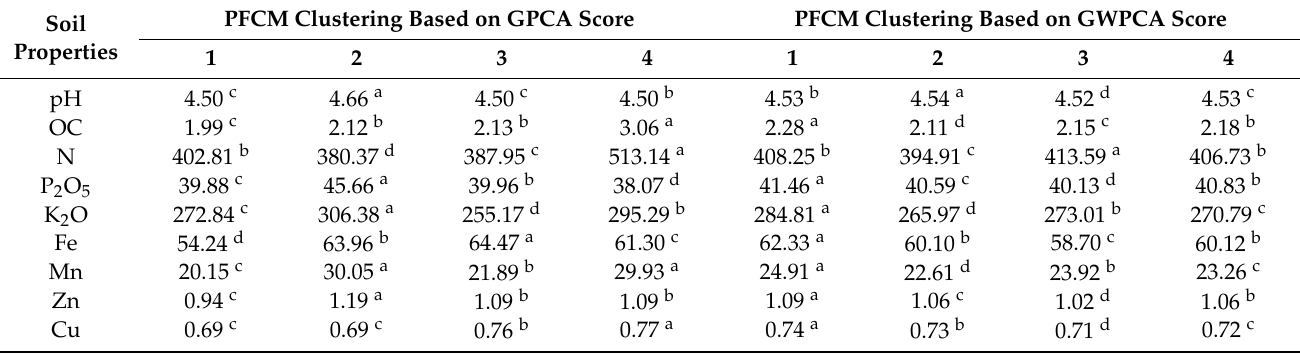
Table 7. Variance analysis of soil properties in management zones and Tukey multiple comparisons